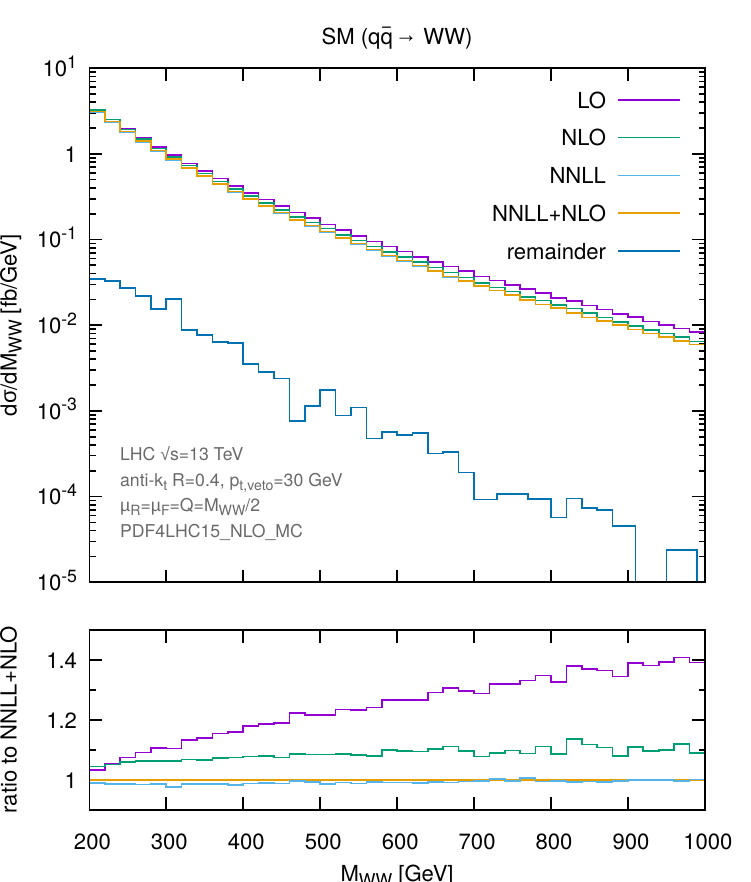
Figure 1 . The di(cid:11)erential distribution d(cid:27)=dM WW in the Standard Model, computed at di(cid:11)erent accuracies, and for the cuts described in the main